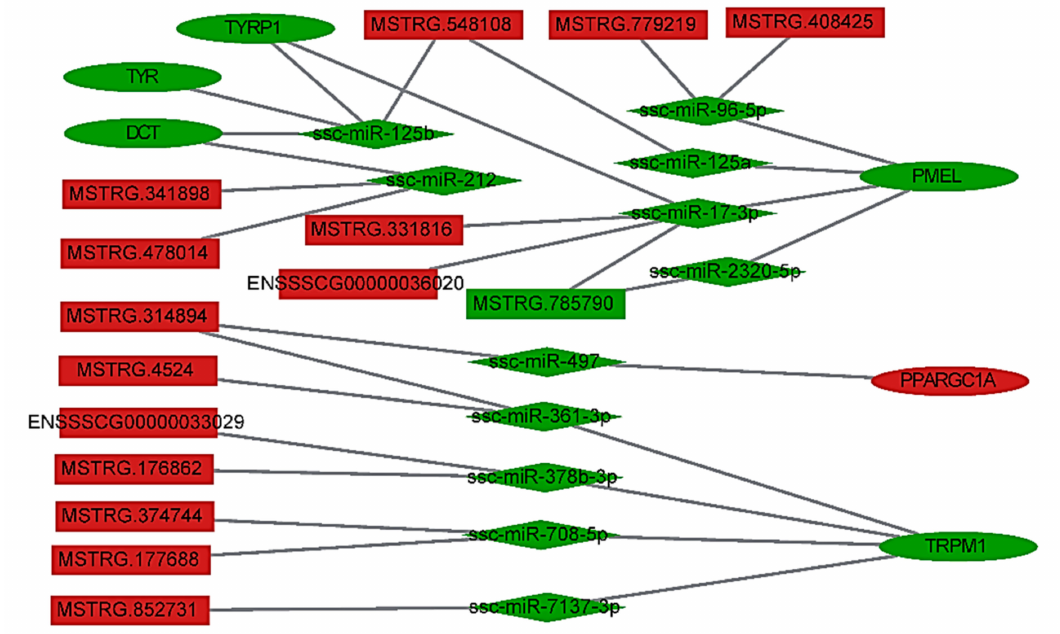
Figure 5. LncRNA–miRNA–gene interaction network. Rectangles, diamonds and ovals represent lncRNAs, miRNAs and genes, respectively. Red indicates that the RNA is relatively more abundant, and green indicates that the RNA is relatively less abundant in white skin than in black